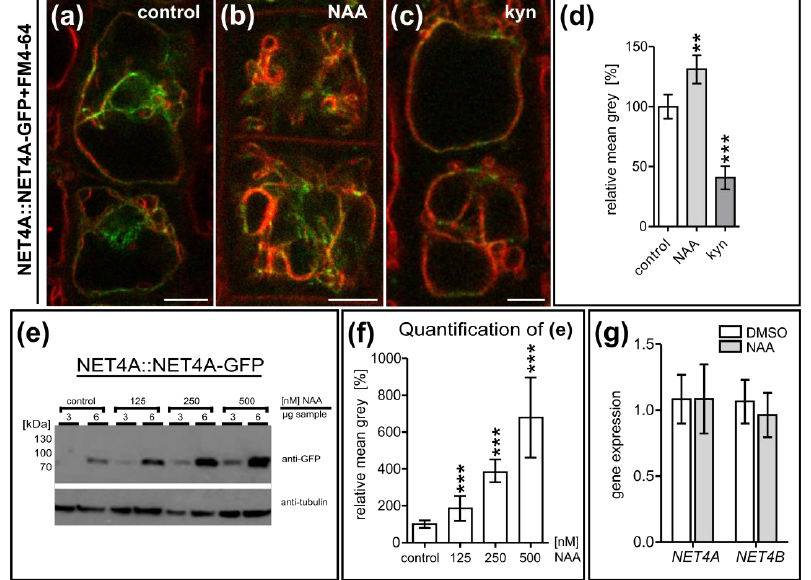
Figure 2. NET4A localizes to highly constricted vacuolar membranes. ( a – c ) Altered NET4A-GFP protein abundance upon exogenous auxin (NAA) application and depletion by the auxin biosynthesis inhibitor kynurenine (kyn). Seedlings were treated with DMSO as control ( n = 17), 250 nM NAA ( n = 15) and 3 µM kyn ( n = 15). Five cells per root were considered. ( d ) Quantification of signal intensity. ( e ) Western blot analysis of NET4A-GFP (endogenous promoter) abundance upon rising NAA concentration. Arabidopsis root tissue was probed using a GFP-antibody. To avoid signal saturation, two di ff erent sample concentrations were loaded (3 and 6 µ g). ( f ) Signal intensity of the individual NET4A-GFP bands were quantified in respect to the corresponding tubulin control bands. ( g ) To test for auxin-induced gene expression changes, qRT-PCR for both NET4 family members, NET4A and NET4B , was carried out. Error bars represent s.e.m. Student’s t -test, p -values: ** p < 0.01; *** p < 0.001. Scale bars: 5 µ